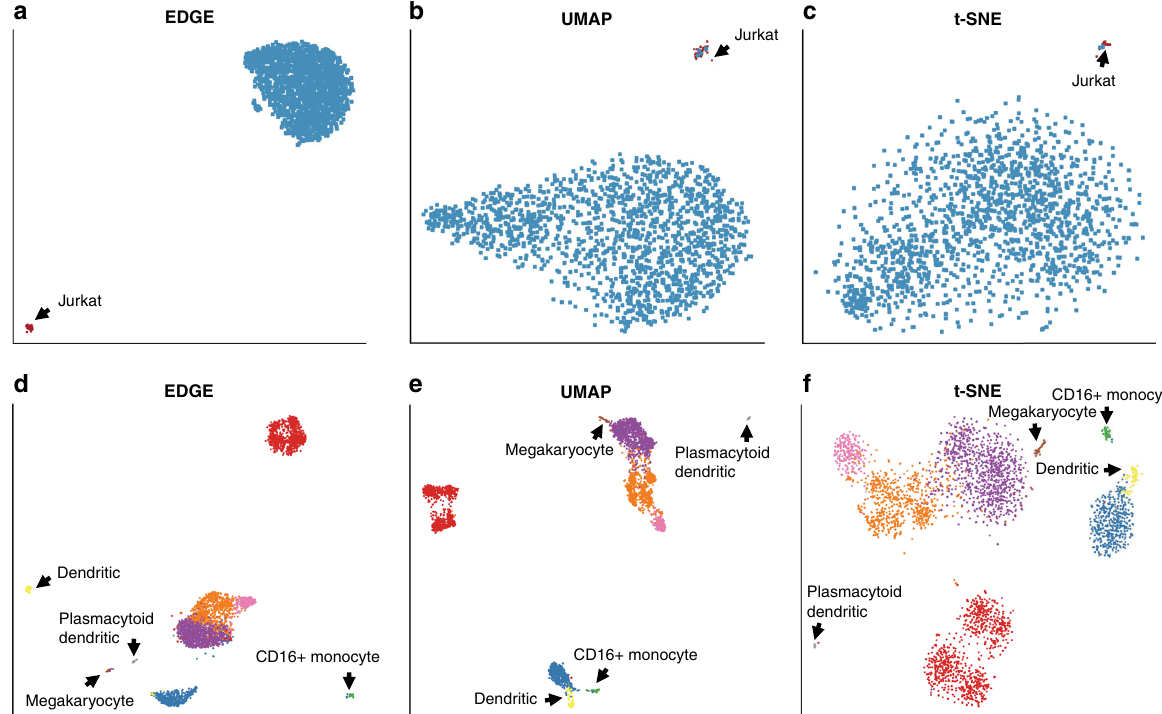
Fig. 3 Detection of rare cell types. a – c The two-dimensional embeddings learnt by EDGE, UMAP, and t-SNE, respectively, on the Jurkat dataset. d – f The two-dimensional embeddings learnt by EDGE, UMAP, and t-SNE, respectively, on the PBMC dataset. Black arrows annotate rare cell